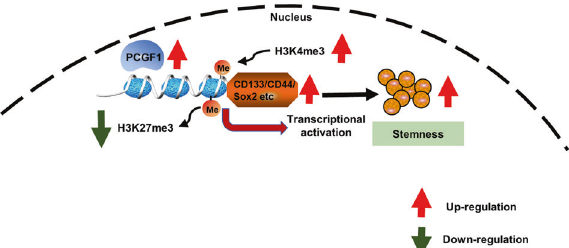
Fig. 7 A diagram of the mechanisms by which PCGF1 promotes colorectal cancer stem cell enrichment. Schematic fi gure showing that PCGF1 promotes colorectal cancer stem cell enrichment by maintaining H3K4me3 marks and removing H3K27me3 marks at the promoters of stemness